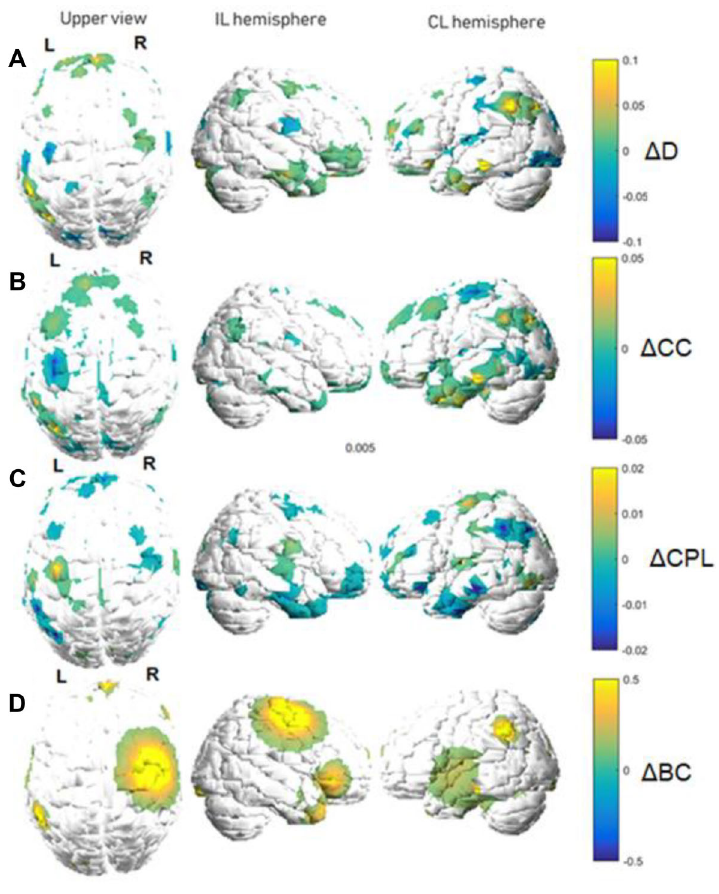
Figure 2. Graph metric changes between functional magnetic resonance imaging acquisitions (motor stroke group). Variations are shown in a relative color scale, according to Equation 6. A , degree (D); B , clustering coef fi cient (CC); C , characteristic path length (CPL); D , betweenness centrality (BC). IL: ipsilesional; CL: